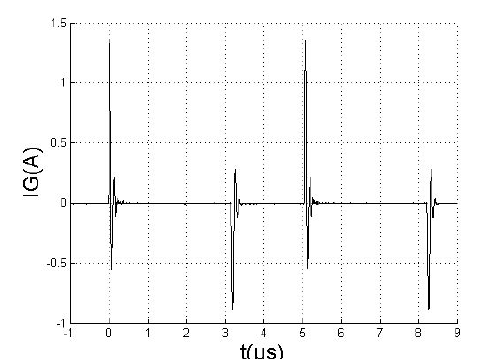
Figure 19: Experimental waveform of the current i